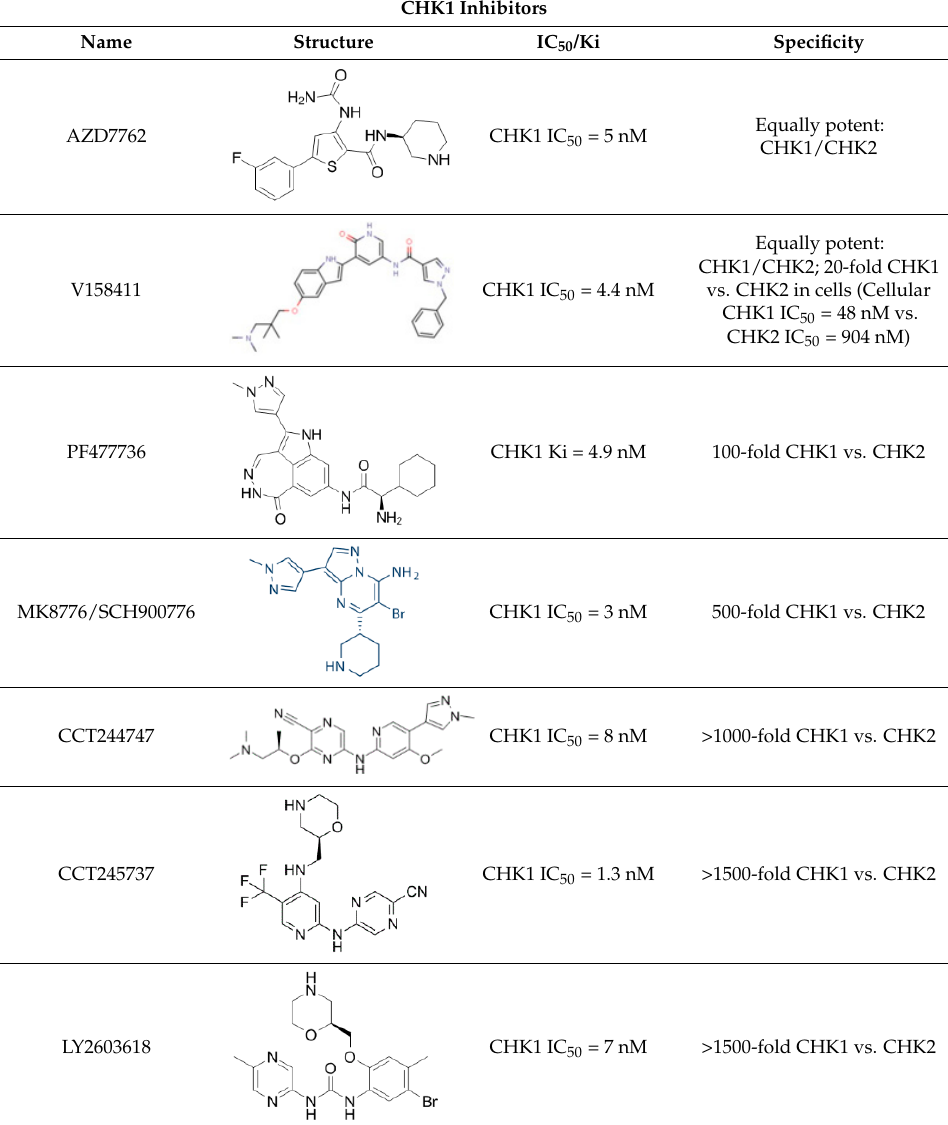
Table 1. Potent and specific small molecule inhibitors of ATR and CHK1.